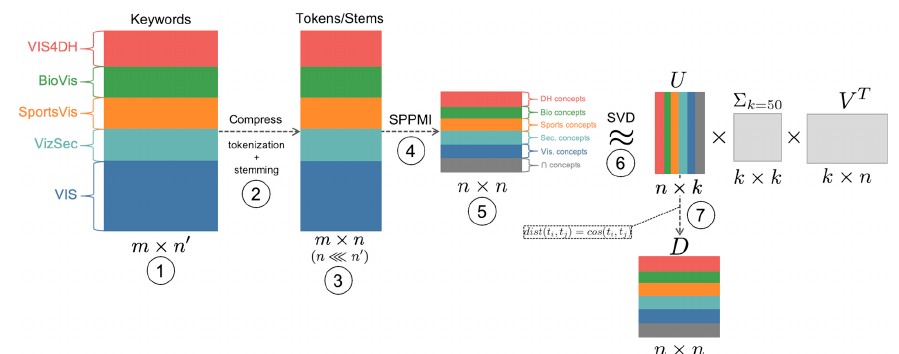
Figure 4. Diagram depicting the generation of distributional embeddings from keywords found in research papers. (1) Term-document matrix containing documents in the source (S-) and target (T-) literatures. (2) Keywords are tokenized and stemmed, (3) effectively reducing the number of columns in the term-document matrix. (4) An SPPMI matrix is built from annotating co-occurring keyword tokens in the corpus. (5) Rows in the resulting square matrix are sorted according to each token’s provenance. Finally, the matrix is decomposed into the product of three matrices employing singular value decomposition (SVD). Vectors representing each keyword token are obtained from the left singular vectors of the factorization, U (6). Finally, we derive a distance matrix D employing a cosine metric (7) and that we use to extract inter-domain